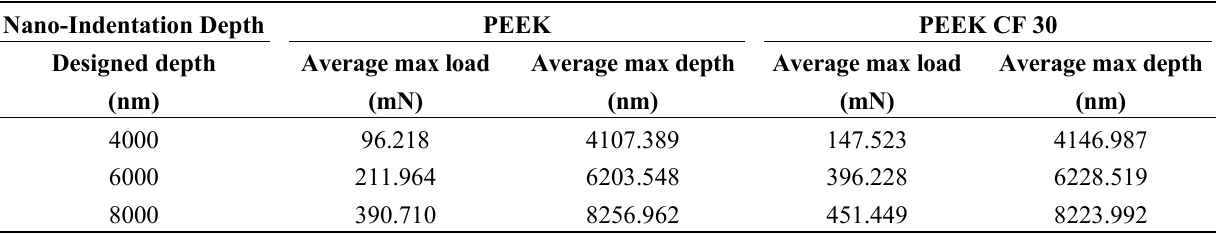
Figure 5. Load as function of indentation depths for both materials ( a ) 4 µm; ( b ) 6 µm; ( c ) 8 µm. Table 2. Nano-indentation data at max